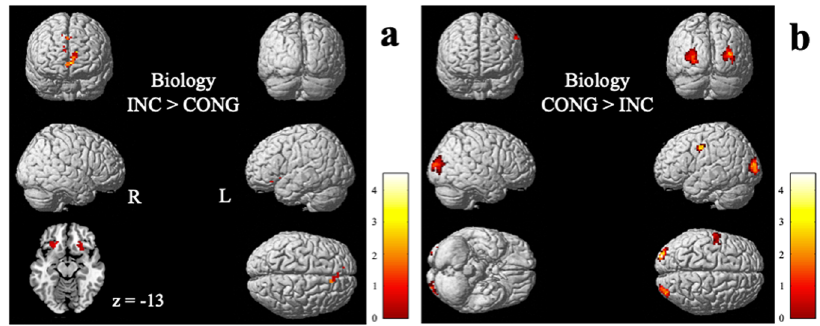
Fig. 6 Activation clusters for t -contrasts associated with statements in biology. a Incongruent statements > congruent statement; b congruent statements > incongruent statement. Clusters are presented at p UNCORRECTED < 0.005 and 3D renders are depicted in the standard single ‐ subject volume ‐ rendered brain implemented in SPM8, while 2D renders are presented in the ch2better template in MRIcron 107 . L left, R right.